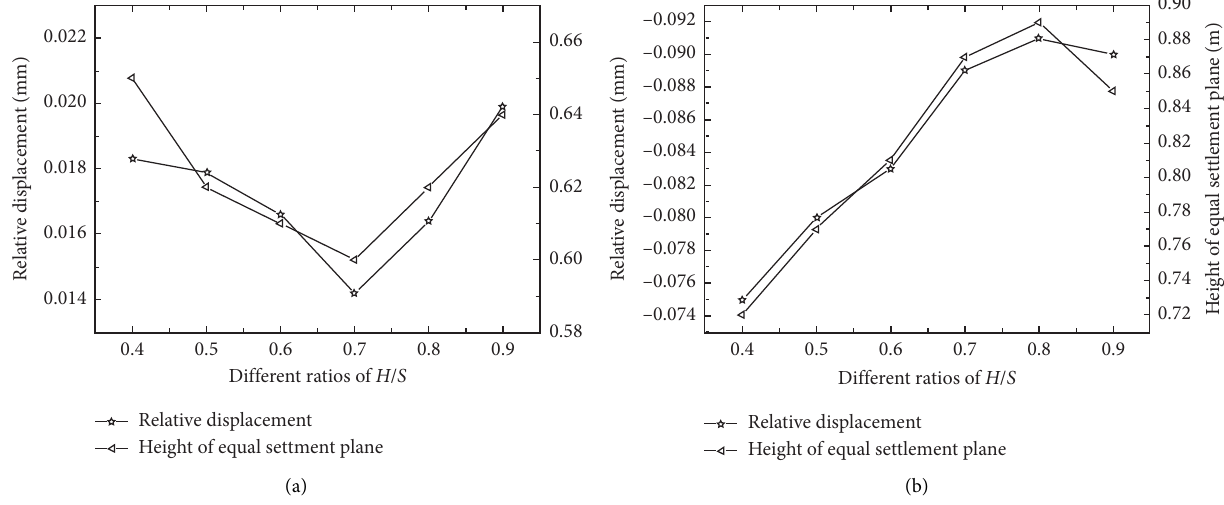
Figure 11: Variations of relative displacement and height of equal settlement plane on top of CCT for cases (a) S1 and (b) S2.